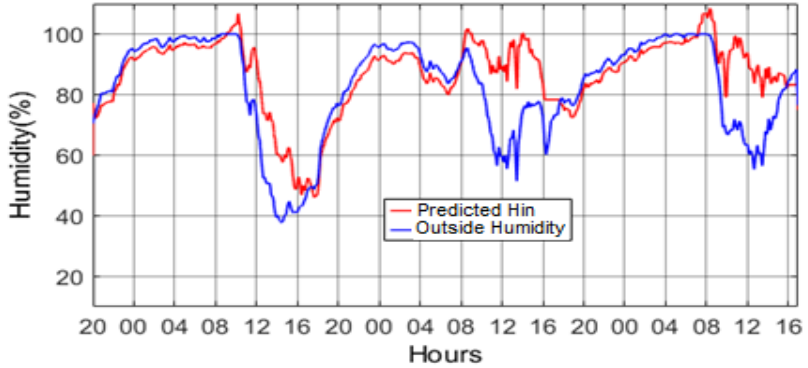
Figure 6. Simulation results of the inside and outside greenhouse humidity.